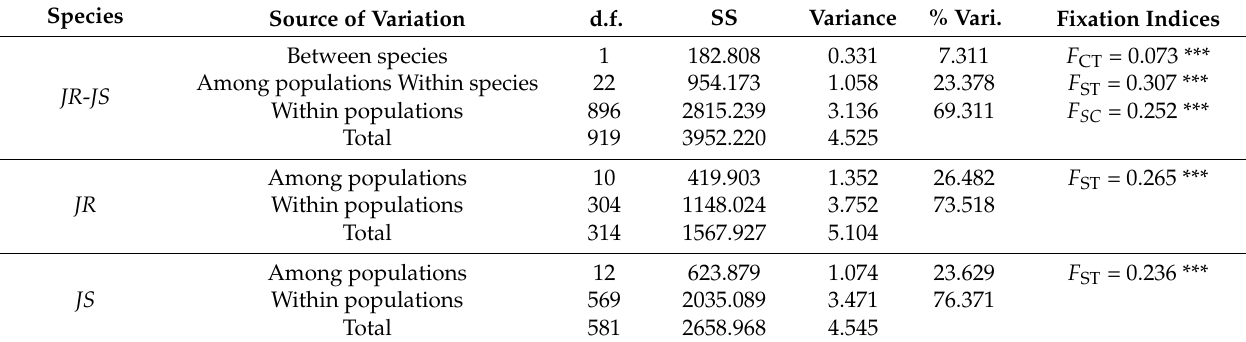
Table 3. Hierarchical analyses of molecular variance (AMOVA) of Juglans samples based on 25 EST-SSR loci.